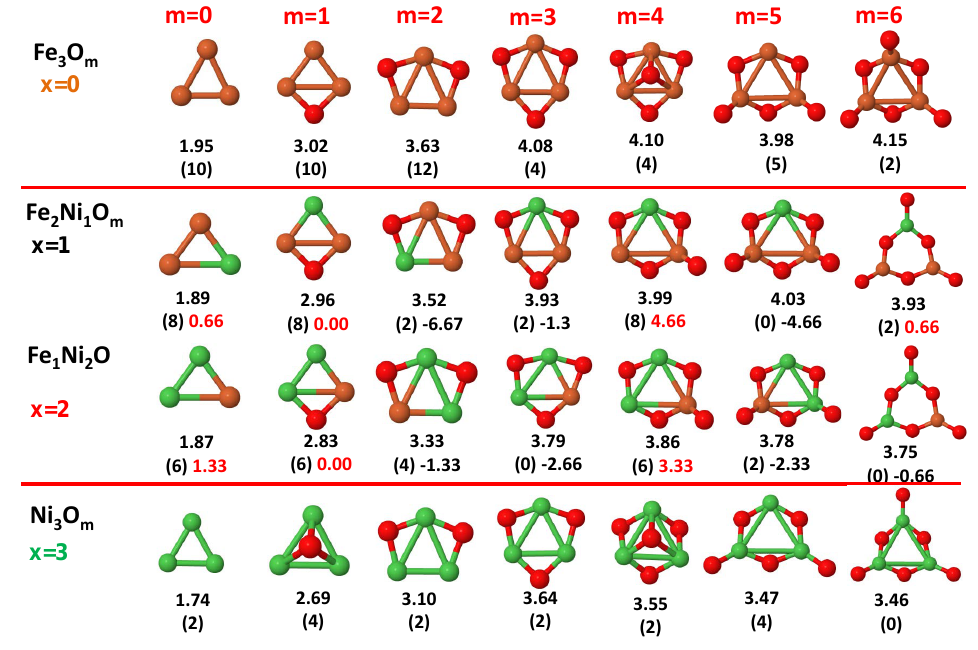
Figure 6. Putative global minimum structures of Fe 3 − x Ni x O m , x = 0–2, m = 1–6. Numbers below structures are the binding energy per atom (in eV), numbers in parentheses are the magnetic moment (in µ B ) and the third number (when present) is the excess magnetic moment (in µ B ) defined in Equation (2). Fe atoms in brown color, Ni atoms in green and oxygen atoms in